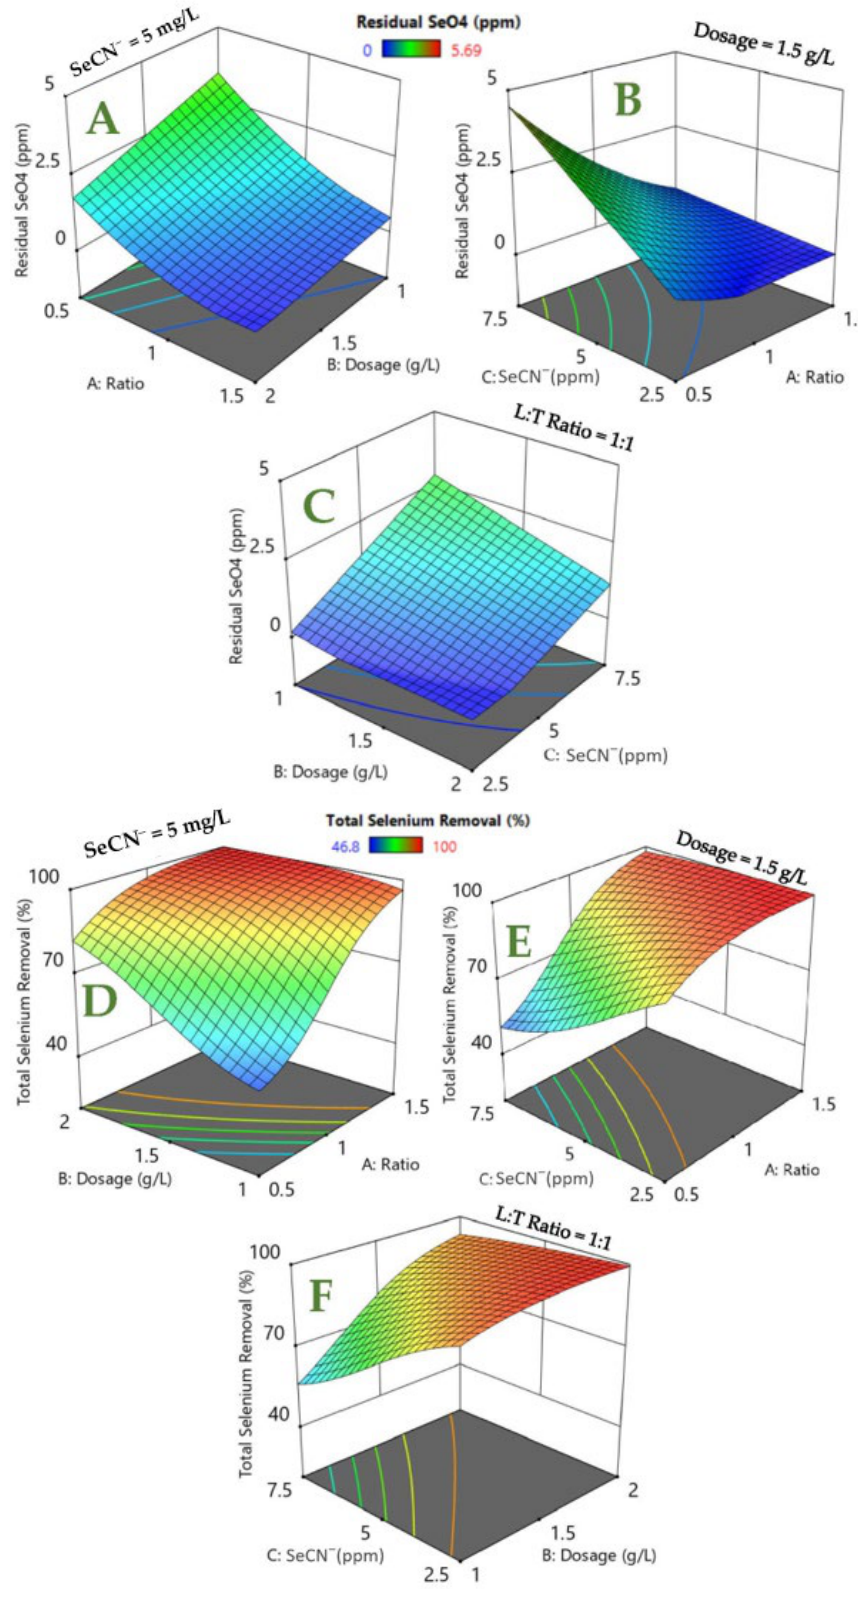
Figure 9. RSM profiles: ( A ) residual SeO 4 2 − (initial SeCN − = 5 mg/L); ( B ) residual SeO 4 2 − ; ( C ) residual SeO 4 2 − . Total selenium removal (%) with; ( D ) total selenium removal; ( E ) total selenium removal; ( F ) total selenium removal.